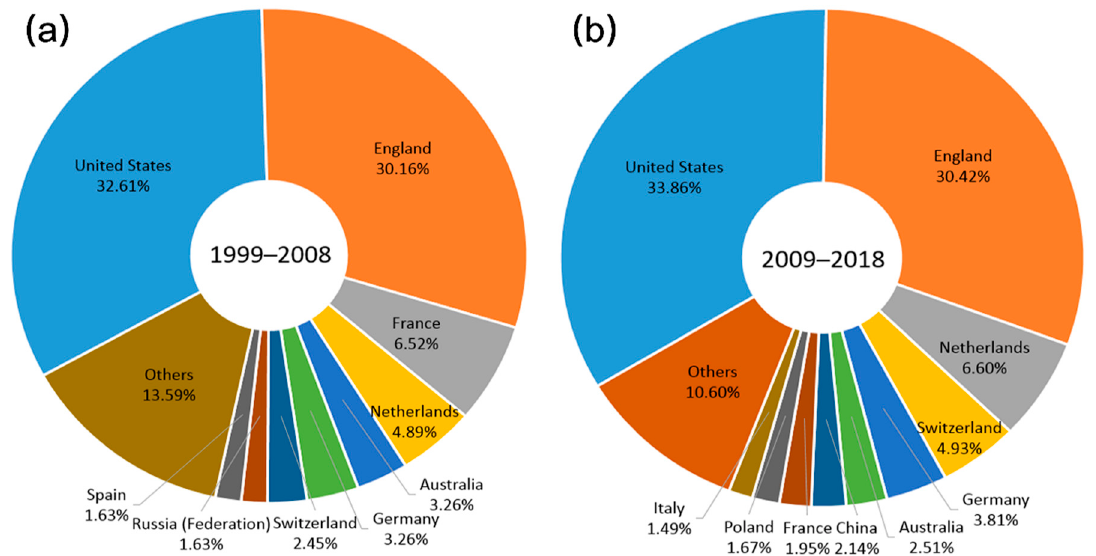
Figure 2. Publication places of journals publishing articles on climate change and infectious diseases. ( a ) Publication places of journals publishing relevant articles from 1999 to 2008; ( b ) publication places of journals publishing relevant articles from 2009 to 2018.